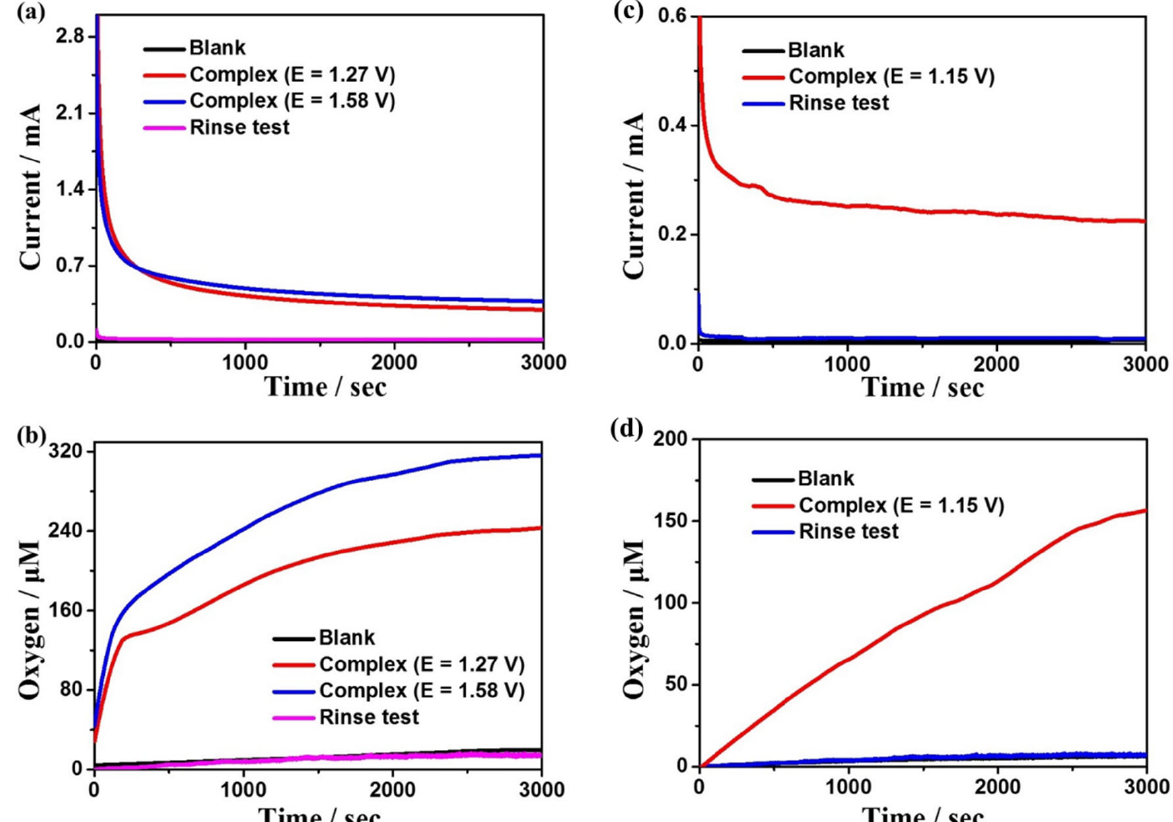
Figure 4. ( a ) CPEs for a solution containing 0.5 mM complex 1 and no complex 1 on the FTO working electrode (1.0 cm − 2 ). ( b ) Dissolved oxygen concentration curves of complex 1 during electrolysis. ( c ) CPEs for a solution containing 0.5 mM complex 2 and no complex 2 on the FTO working electrode (1.0 cm − 2 ). ( d ) Dissolved oxygen concentration curves of complex 2 during electrolysis.